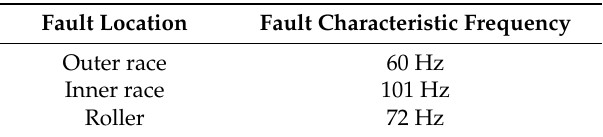
Table 2. Fault characteristic frequency of the roller bearings at 900 rpm.